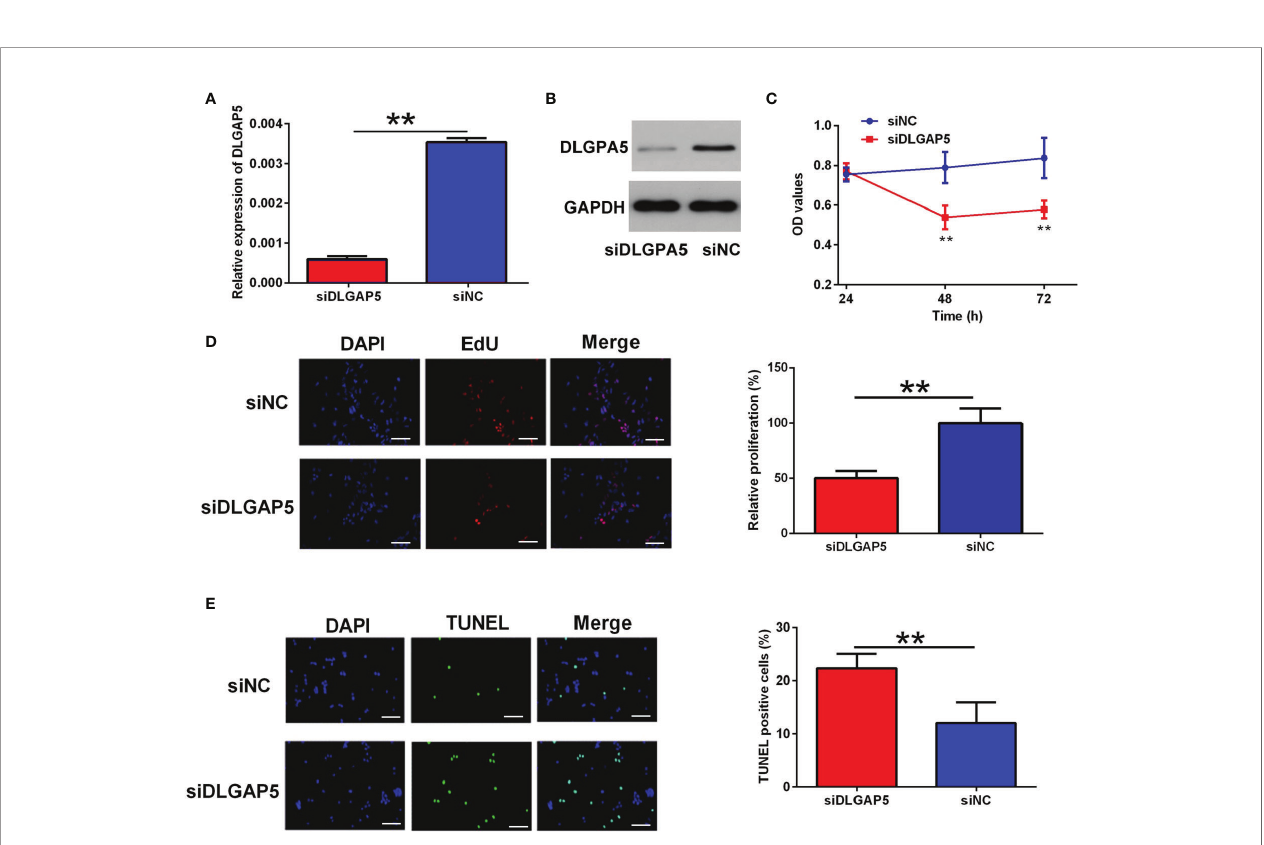
FIGURE 7 | Effects of DLGAP5 knockdown on the granulosa cell proliferation and apoptosis. Granulosa cells were transfected with si-NC or si-DLGAP5, and after siRNA transfection, (A) the mRNA expression level of DLGAP5 in the granulosa cells was determined by qRT-PCR; (B) the protein expression level of DLGAP5 in the granulosa cells was determined by western blot; (C) the cell viability of granulosa cells was determined by CCK-8 assay; (D) the cell proliferation of granulosa cells was determined by EdU assay, scale bar = 50 µm; (E) the cell apoptosis of granulosa cells was determined by TUNEL assay; scale bar = 50 µm. N = 3. **P <